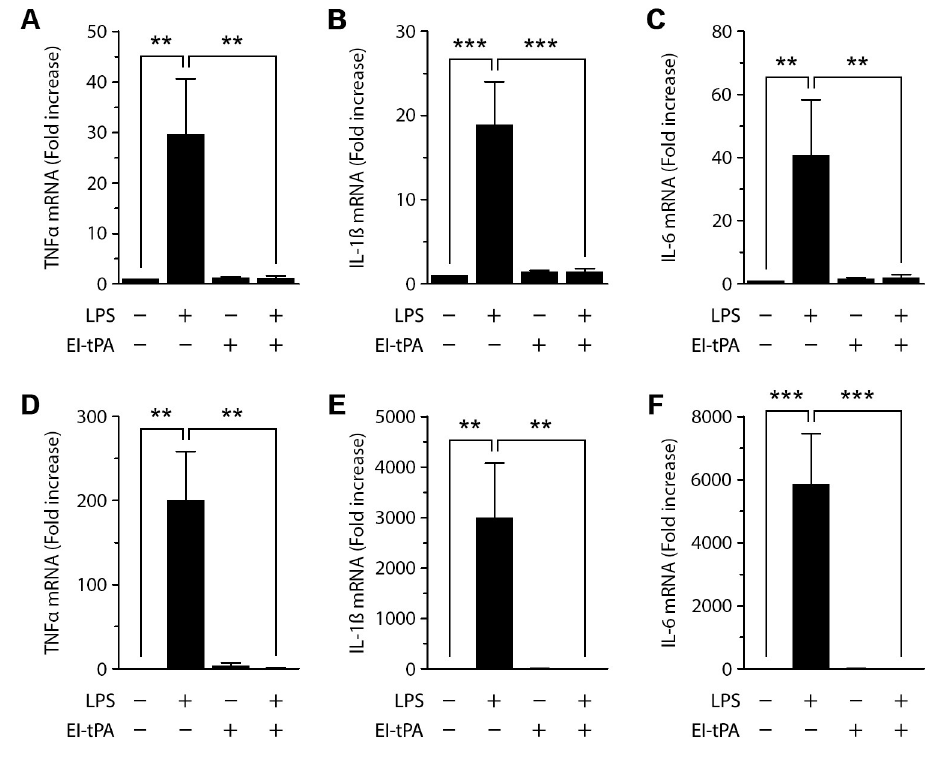
Fig 6. EI-tPA blocks the response to LPS in CSF-1-differentiated PMs by an NMDA-R-dependent pathway. PMs were cultured in basal media supplemented with L929 cell-conditioned medium (panels A-C) or CSF-1 (10 ng/mL) (panels D-F) for 48 h and then treated with LPS (0.1 μ g/mL), EI-tPA (12 nM), LPS plus EI-tPA, or vehicle for 6 h. Expression of TNF α (panels A, D), IL-1 β (panels B, E) and IL-6 (panels C, F) was determined by RT-qPCR (mean ± SEM, n = 3–4; one-way ANOVA with Bonferroni post-hoc test on selected pairs of columns, �� p < 0.01, ��� p < 0.001).